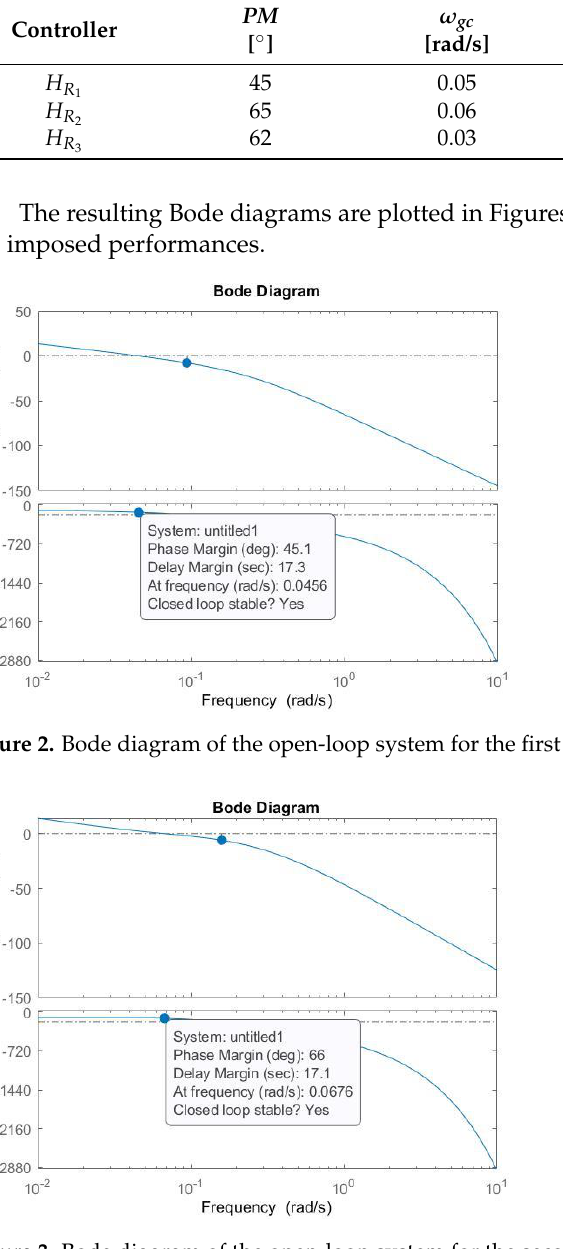
Figure 4. Bode diagram of the open-loop system for the third designed PI controller. The corresponding step responses of the closed-loop system are plotted in Figure 5. Figure 5. Step responses of the closed-loop system for the three designed PI controllers. The second experiment involved the design of a fractional-order PI (FO-PI) control- ler, using the same performance measures as in the integer-order case and, as an addi-